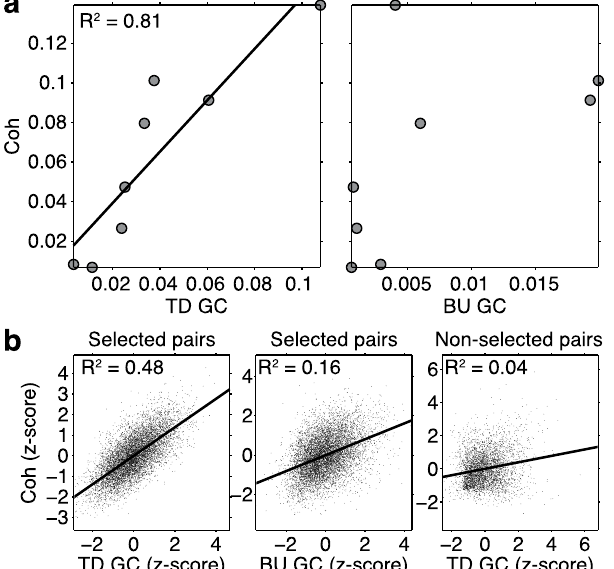
Figure 6. Correlation Between Coherence and sGC. ( a ) Correlation between coherence and top-down (left) and bottom-up (right) sGC at 16 Hz across V1/V2-extrastriate site pairs. Coherence was significantly correlated with top-down sGC (R(6) = 0.90, p = 0.005, Bonferroni corrected), but not with bottom-up sGC. ( b ) Correlation between normalized coherence and top-down (left), and bottom-up (middle) sGC at 16 Hz averaged over the bootstrap resamples of all 8 V1/V2-extrastriate pairs, having their mean peak frequency inside the 95% confidence interval of Fig. 3. The correlation between coherence and top-down and bottom-up sGC explained 48% and 16% of the coherence variance, respectively. Correlation between coherence and top- down (right) sGC at 16 Hz for the other 4 site pairs explained only 4% of the coherence